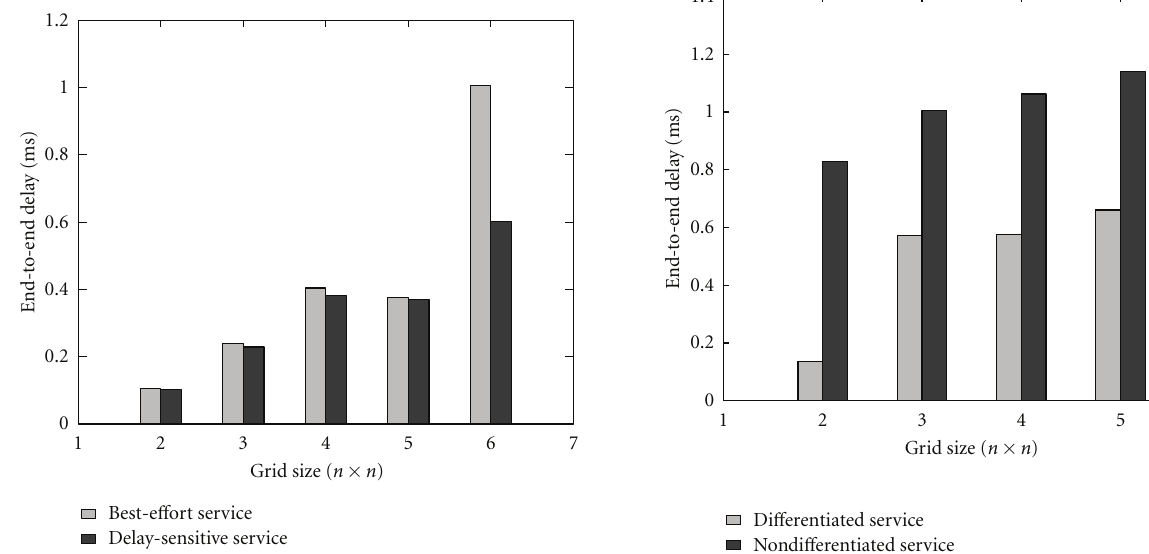
Figure 12: Delay comparison: di ff erentiated and non-di ff erentiated service for delay sensitive